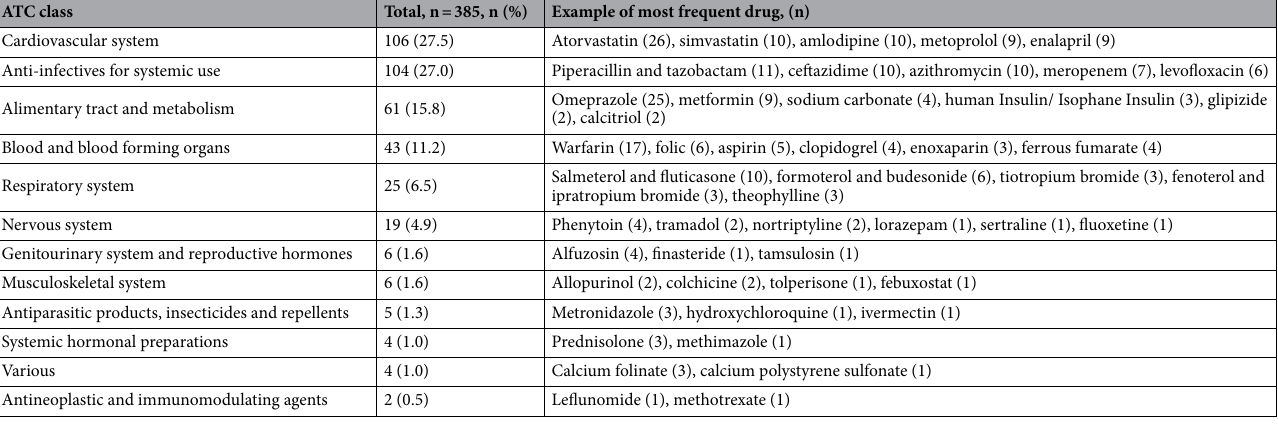
Table 3. Summary of ATC classes and drug involved in drug-related problems. ATC anatomical therapeutic chemical classification system.